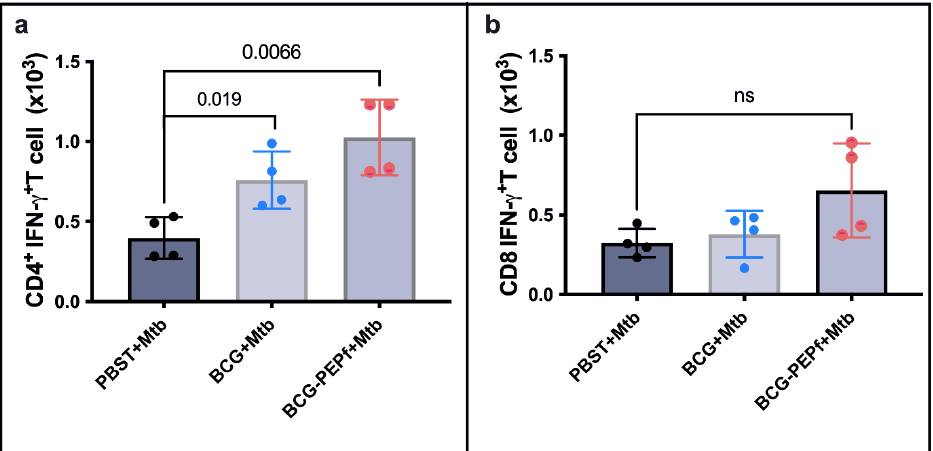
Figure 3. Immunogenicity of the BCG-PEPf vaccine. Forty-five days after immunization, mice were challenged using M. tuberculosis , and 30 days later, the lung cells from BALB/c PBST vaccinated (PBST + Mtb), immunized with BCG (BCG+Mtb), or BCG-PEPf (BCG-PEPf + Mtb) were analyzed after PEPf stimulation. ( a ) CD4 + IFN- γ + T cells and ( b ) CD8 + IFN- γ + PEPf-specific T cells in the lungs were determined. The p -value is shown above the compared bars between significantly different groups. Data shown (circles) represent the cell numbers for each individual animal, and the bars show the average (with SD) for each group. The results represent one of two independent experiments. ns, difference non-significant.